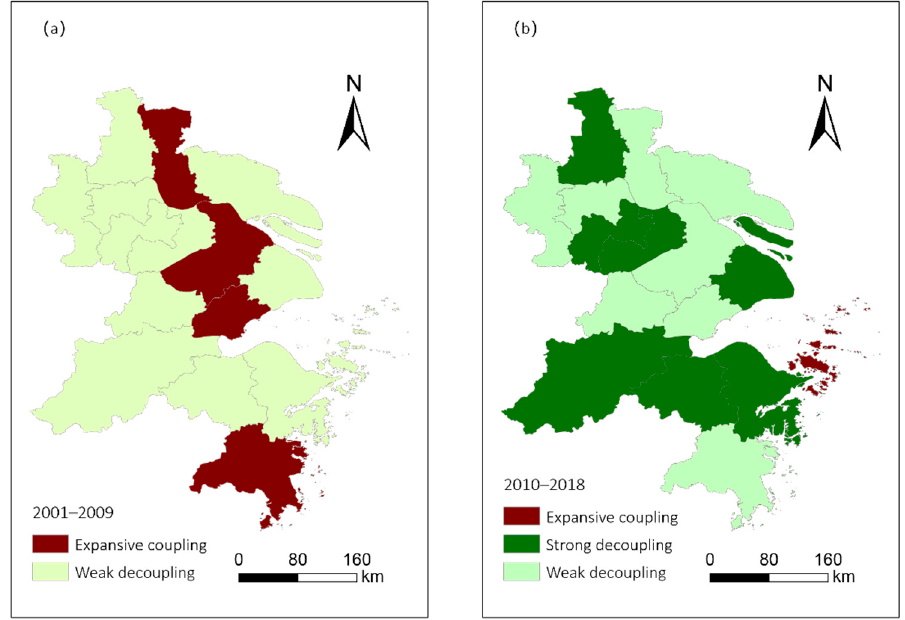
Figure 5. The decoupling characteristics of the carbon footprint pressure and economic growth for the period of 2001 to 2009 ( a ) and 2010 to 2018 ( b ). Table 5. The q values of different covariates under interaction